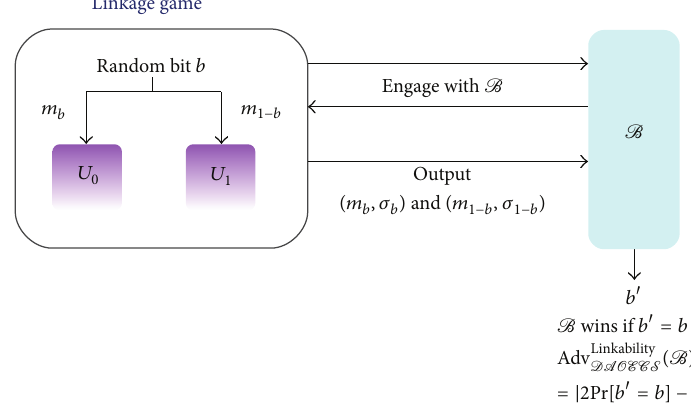
Figure 5: The game environment of linkage